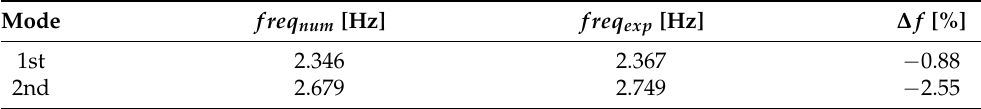
Table 4. Comparison between numerical and experimental frequencies.